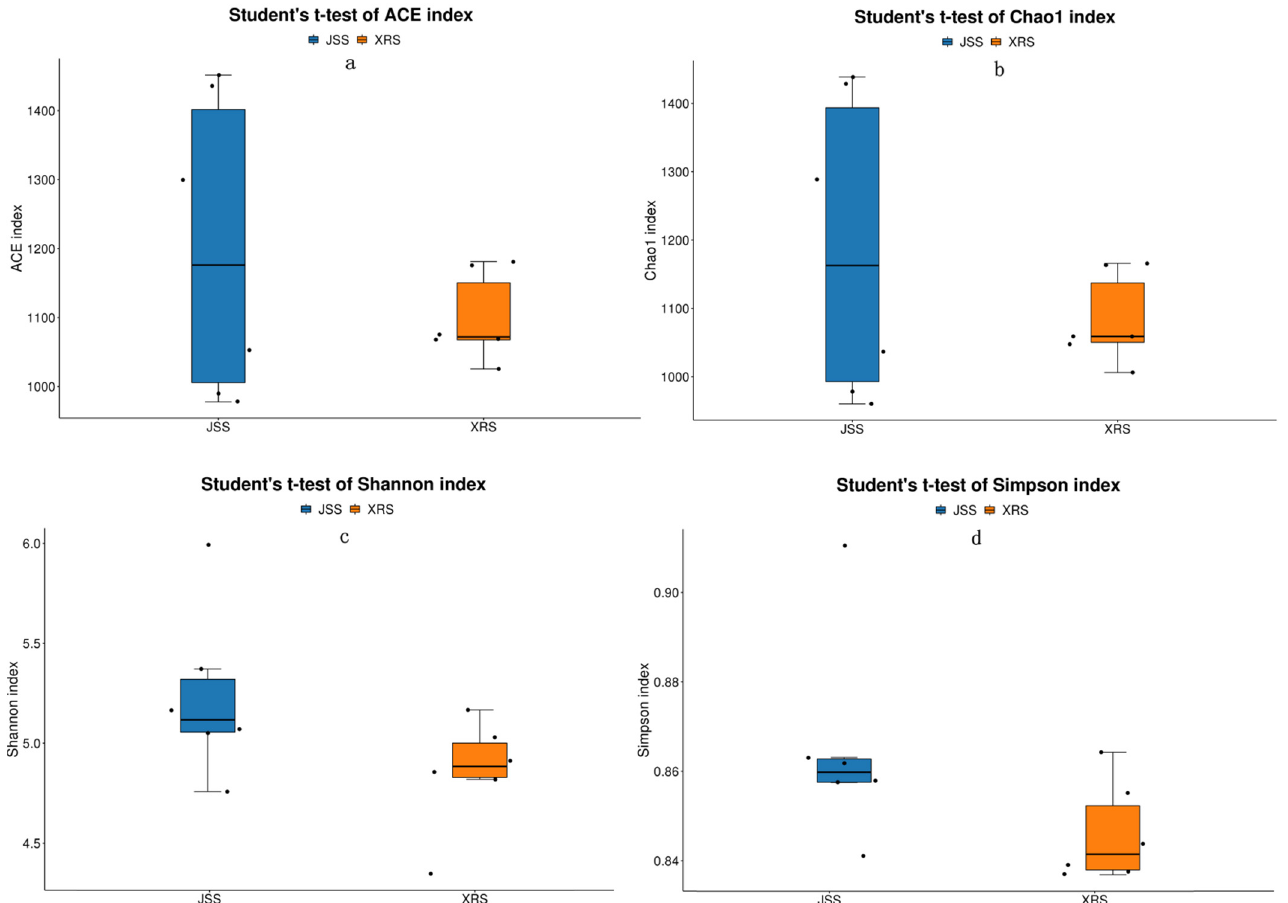
Figure 4. Alpha diversity index of fungi among different groups. ( a ) ACE; ( b ) Chao1; ( c ) Shannon; ( d ) Simpson. One dot represents significant difference ( p < 0.05) and two dots represent highly significant difference ( p < 0.01) between treatments. JSS: the bulk soil sample; XRS: soil of the P. sibiricum rhizosphere.